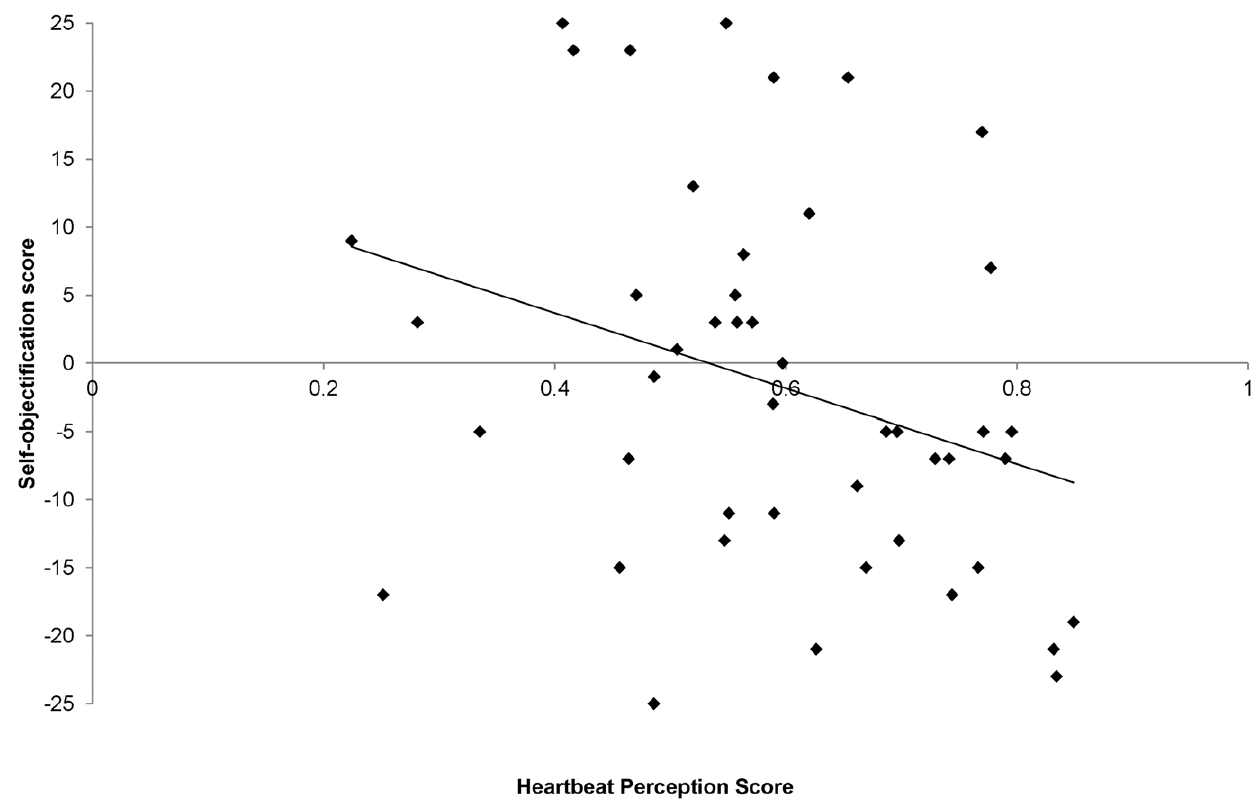
Figure 1. Scatter plot of self-objectification scores against interoceptive awareness.